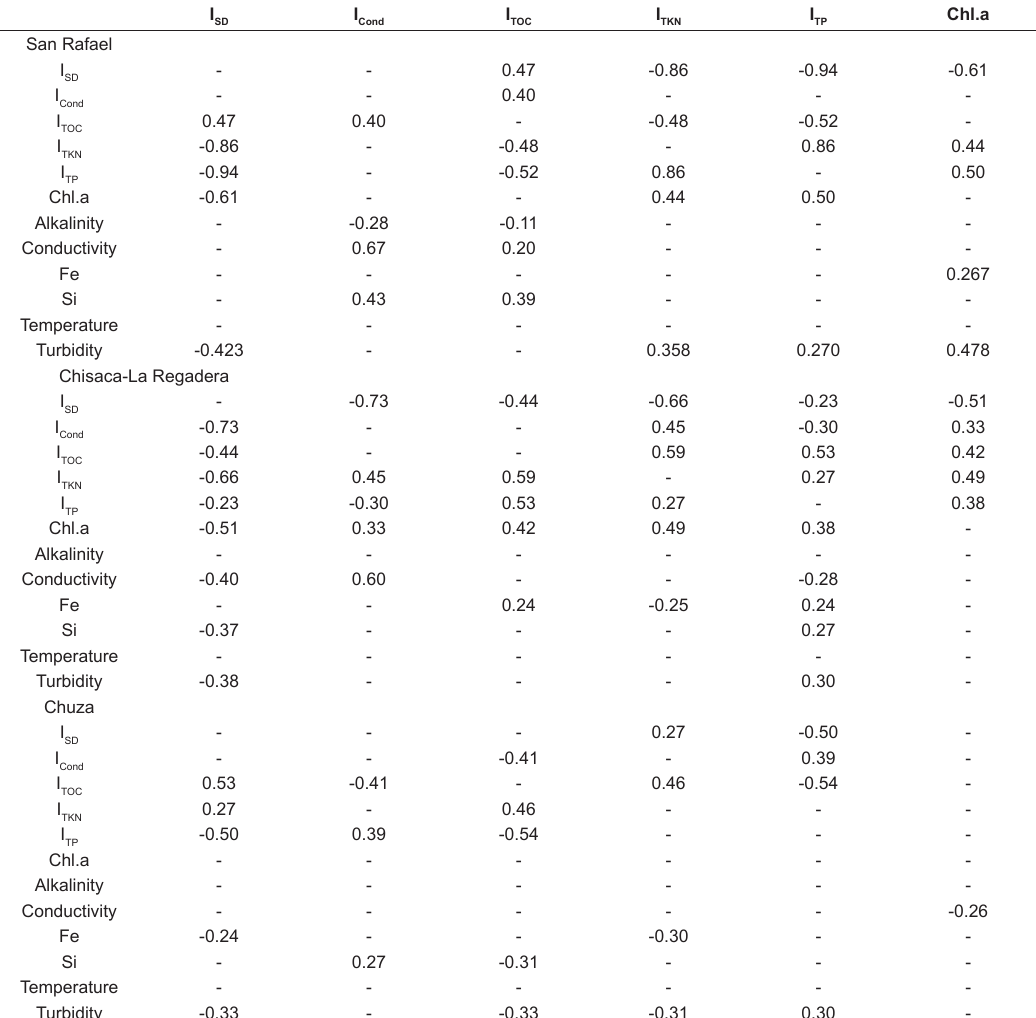
Table 7. Pearson correlation between the trophic index and Chlorophyll-a for San Rafael (n=183), Chisacá-La Regadera (n=76), and Chuza (n=93) reservoirs.